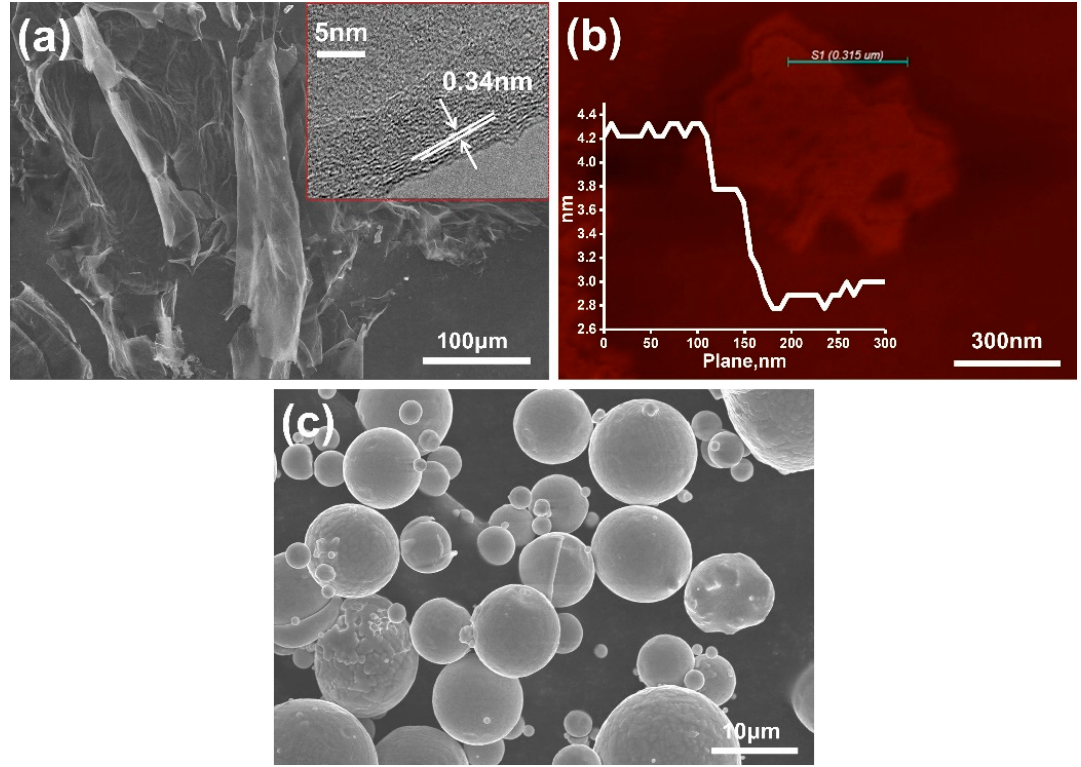
Figure 2. Microstructure of the GNSs and FGH96 powder used in the present paper. ( a ) SEM images of GNSs (the image in the upper right corner is the TEM image of GNSs with a 0.34 nm single layer thickness); ( b ) AFM images of the GNSs with a total thickness of 1.2–1.4 nm; ( c ) SEM images of the